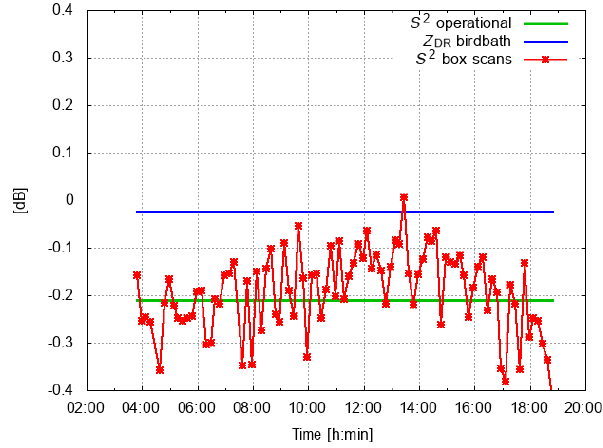
Figure 11. Antenna gain time series in H and V during 3 June 2018 (UTC). Also shown is the antenna gain estimate from operational monitoring (monitoring H, monitoring V) and the gain estimate us- ing DRAO data only.